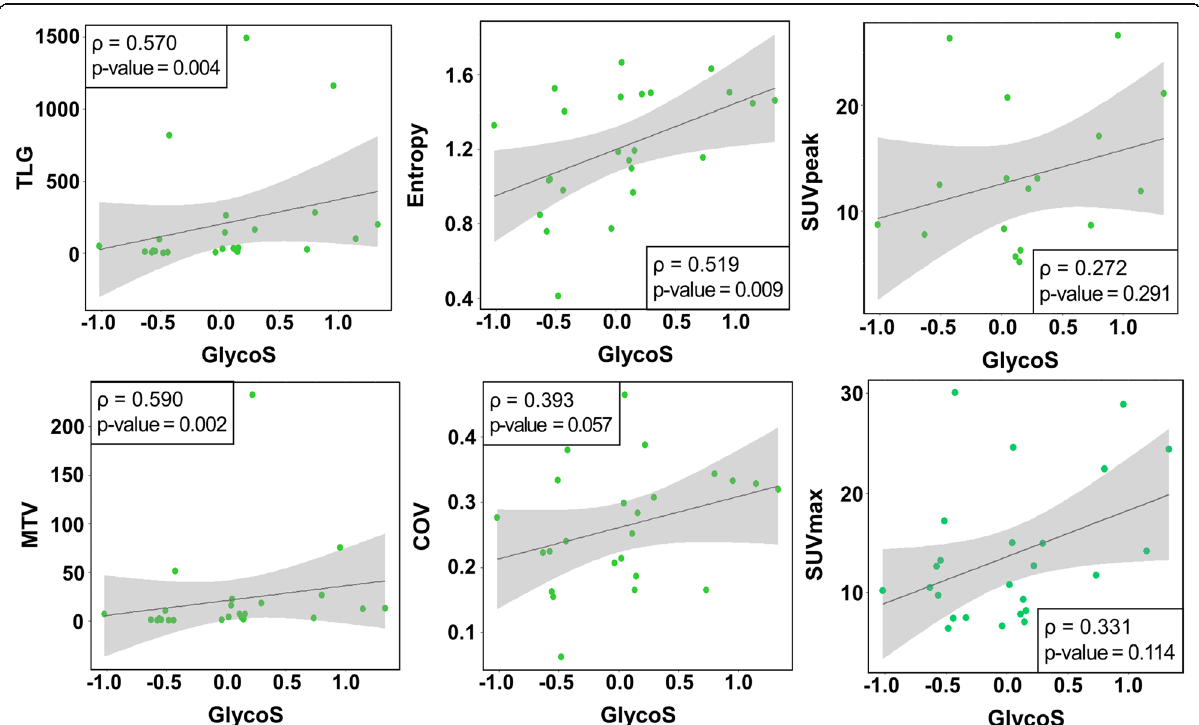
Fig. 3 Correlation between GlycoS and FDG PET features. Scatter plots for correlation analysis of GlycoS and FDG PET features. Each green dots represent patients available for MATH and radiomic data ( N = 25). Upper left box shows Spearman correlation coefficient ( ρ ) and P value. The dark gray line means a linear regression line and the gray region is 95% confidence